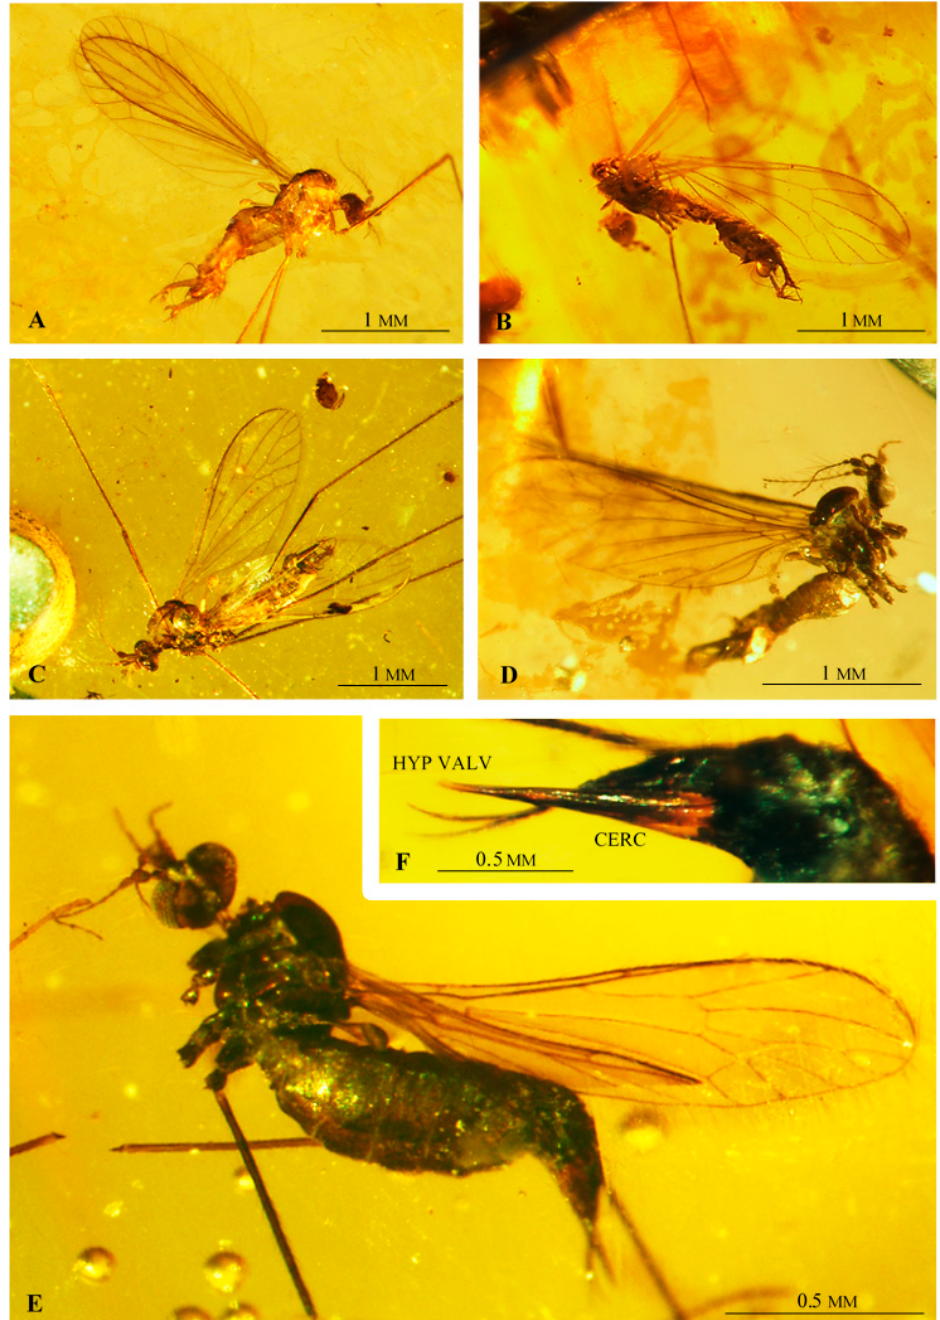
Figure 5. Drinosa prisca Podenas et Poinar, 2009 [13]. ( A ) No. MP/4072 (male) (ISEA PAS), body, lateral view; ( B ) No. MP/4073 (male) (ISEA PAS), body, lateral view; ( C ) No. MP/4070 (male) (ISEA PAS), body, latero—dorsal view; ( D ) No. MP/4068 (male) (ISEA PAS), lateral view; ( E ) No. MP/4074 (female) (ISEA PAS) body, lateral view; ( F ) No. MP/4074 (female) (ISEA PAS) ovipositor, lateral view. Abbreviation as in Figure 2.